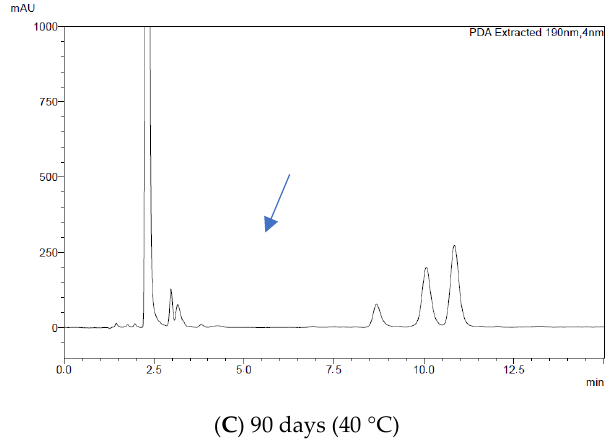
Figure 9. HPLC chromatograms for the samples in the stability study after ( A ) 30 days, ( B ) 60 days, and ( C ) 90 days.